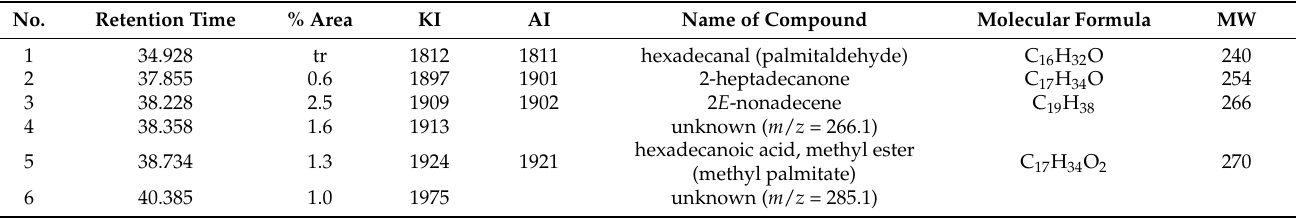
Table 7. Chemical composition of fraction